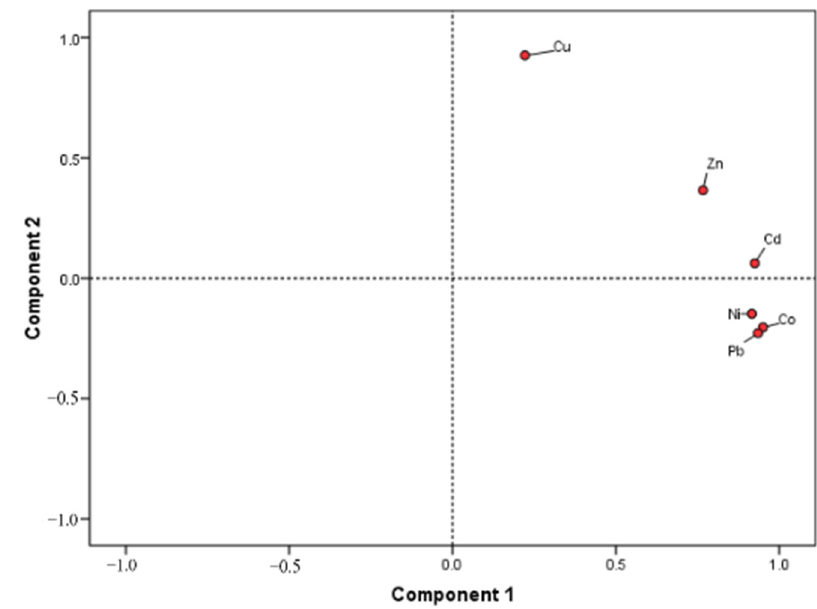
Figure 4. Distribution of heavy metal load in the soils.